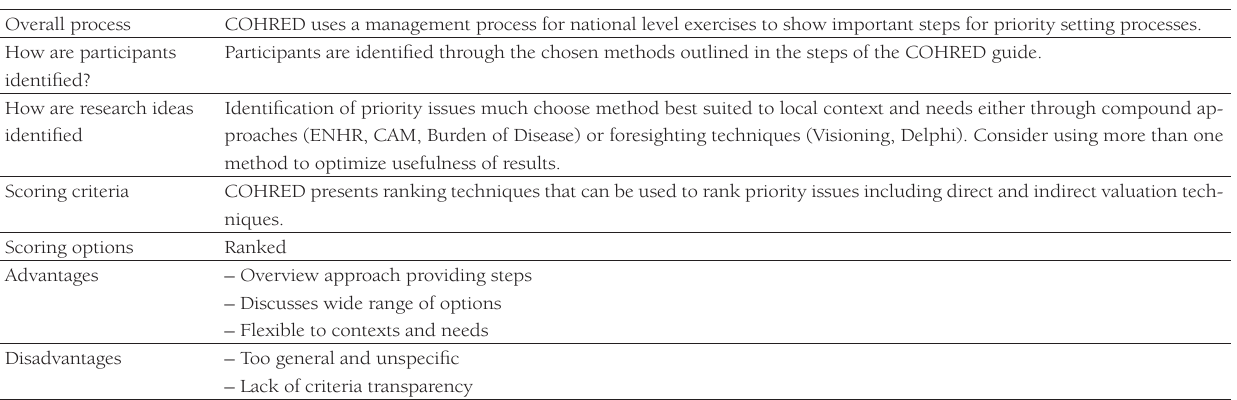
Table 4. Brief explanation of the Council on Health Research for Development (COHRED) [10] Overall